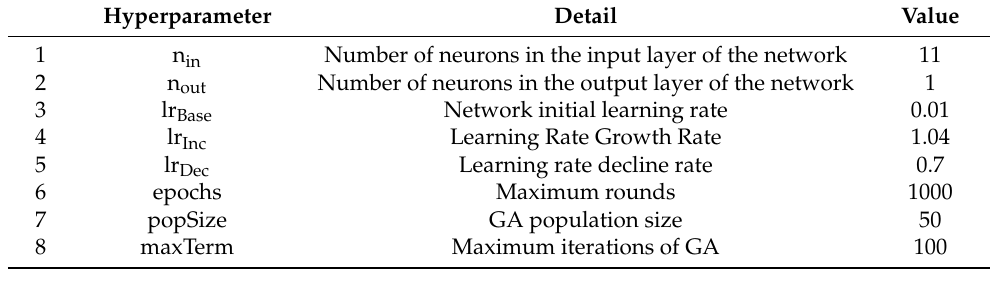
Table 4. Network hyperparameter settings.